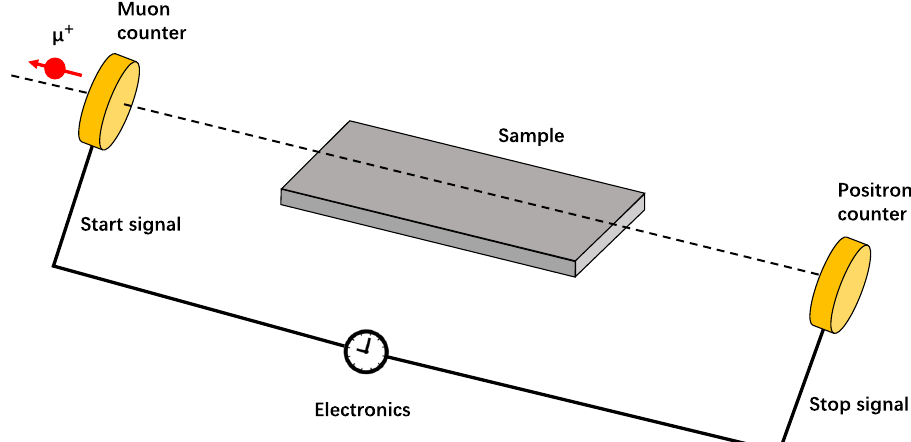
Fig. 5 Schematic of the experimental setup to probe the new spin-dependent interactions for muons. The incoming muon beam which is spin-polarized triggers the clock which defines time zero. A sample is placed close to the muon beam and its polarization can be rotated if new spin-dependent interactions exist. The rotation angle of the muon polarization can be measured from the positron